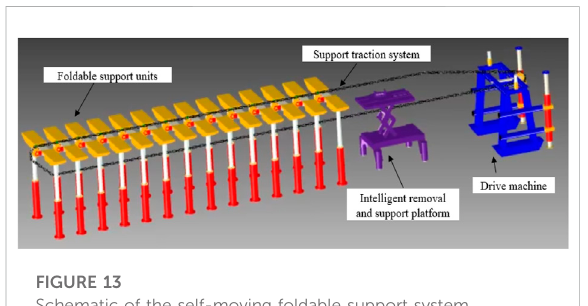
FIGURE 13 Schematic of the self-moving foldable support system.